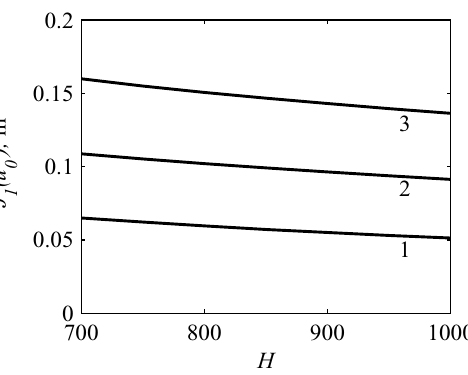
Fig. 7. J 1 ( u 0 ) as a function of H for various v 0 : Curve 1 – v 0 = 40 km/h; curve 2 – v 0 = 50 km/h; curve 3 – v 0 = 60 km/h. of Eqs (46) and (47) in the dimensional variables, multiply the right-hand sides of the cited relations by v 5 / 3 and change ∆ to H 2 / 3 ∆ /v